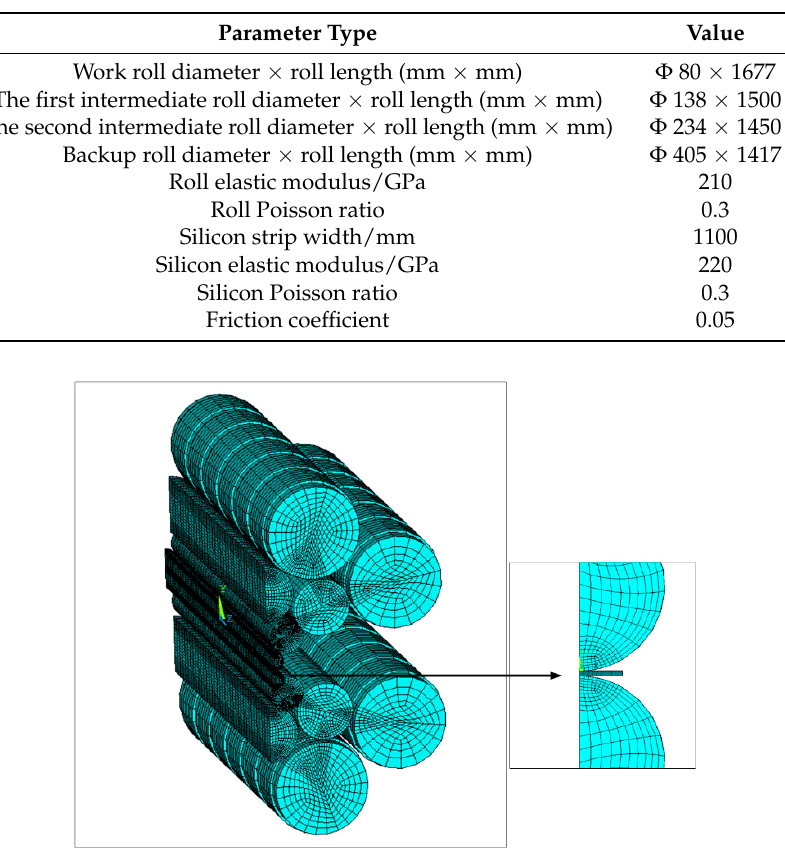
Table 1. Key parameters for the finite element model.